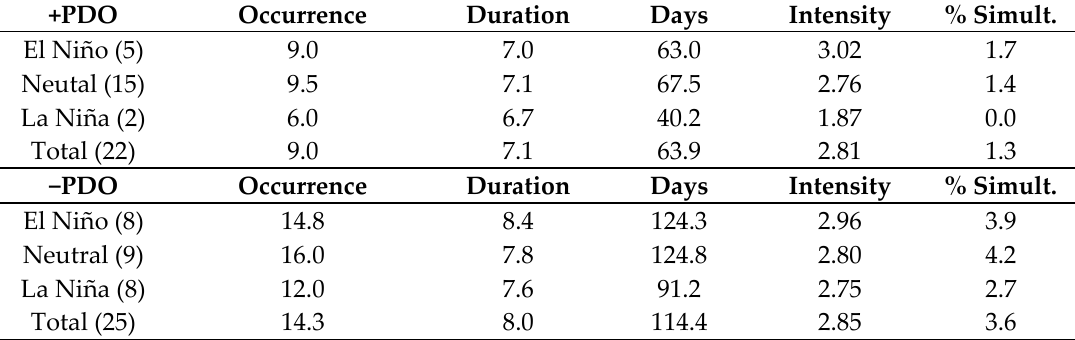
Table 5. Character of Southern Hemisphere blocking events per year as a function of ENSO and PDO. The number of years in each category is shown in